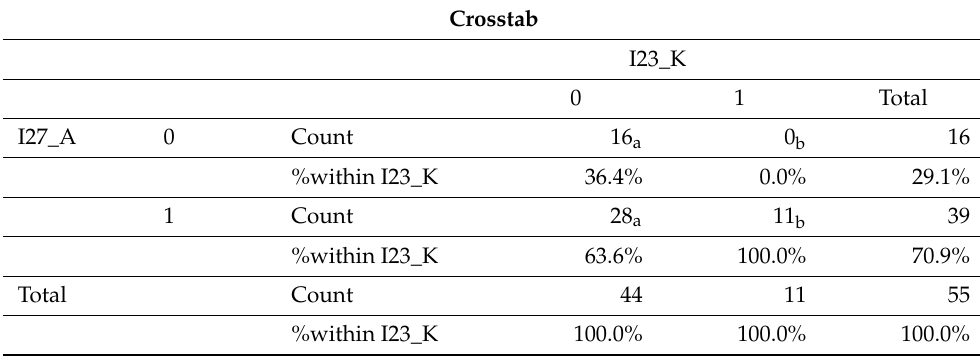
Table 5. Reparation due to failure of the esthetic component and the metallic casted framework with cemented crowns used at the maxilla. Each subscript letter denotes a subset of I23_K categories whose column proportion do not differ significantly from each other at the 0.05 level. Test: Fischer’s Exact test, p value = 0.022928.